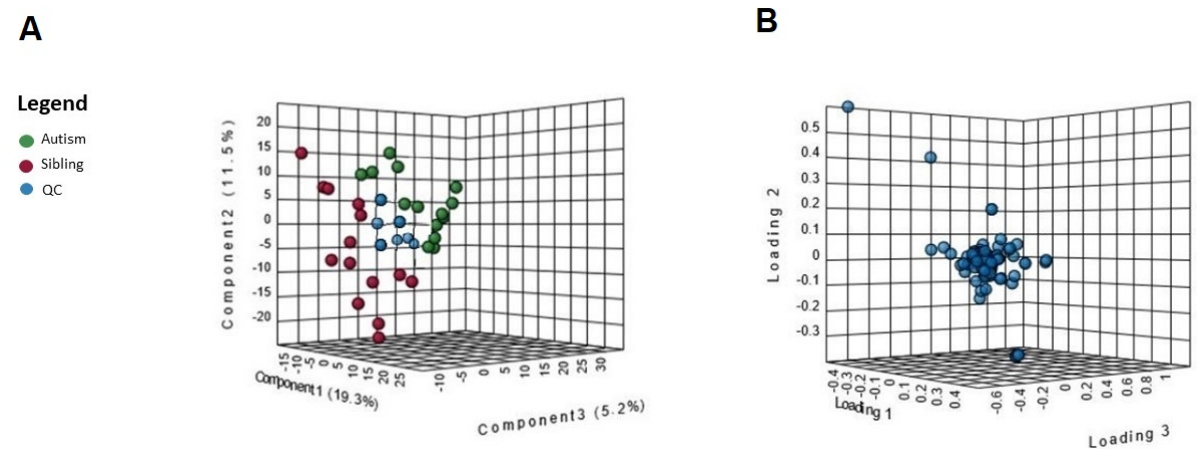
Figure 1. ( A ) Multivariate statistical analysis based on untargeted metabolite profile data derived from urine samples of ASD patients (red), typically-developing siblings (green) and quality controls (blue). Principal component analysis (PCA) in 3D based on normalized and mean-centered data of the 28 samples after outlier removal. Each sphere represents one sample. Axes are principal components 1 (x) and 2 (y), explaining 19.3% and 11.5% of the variation in the data, respectively. ( B ) Loading plots of the first two principal components for the platform metabolites.